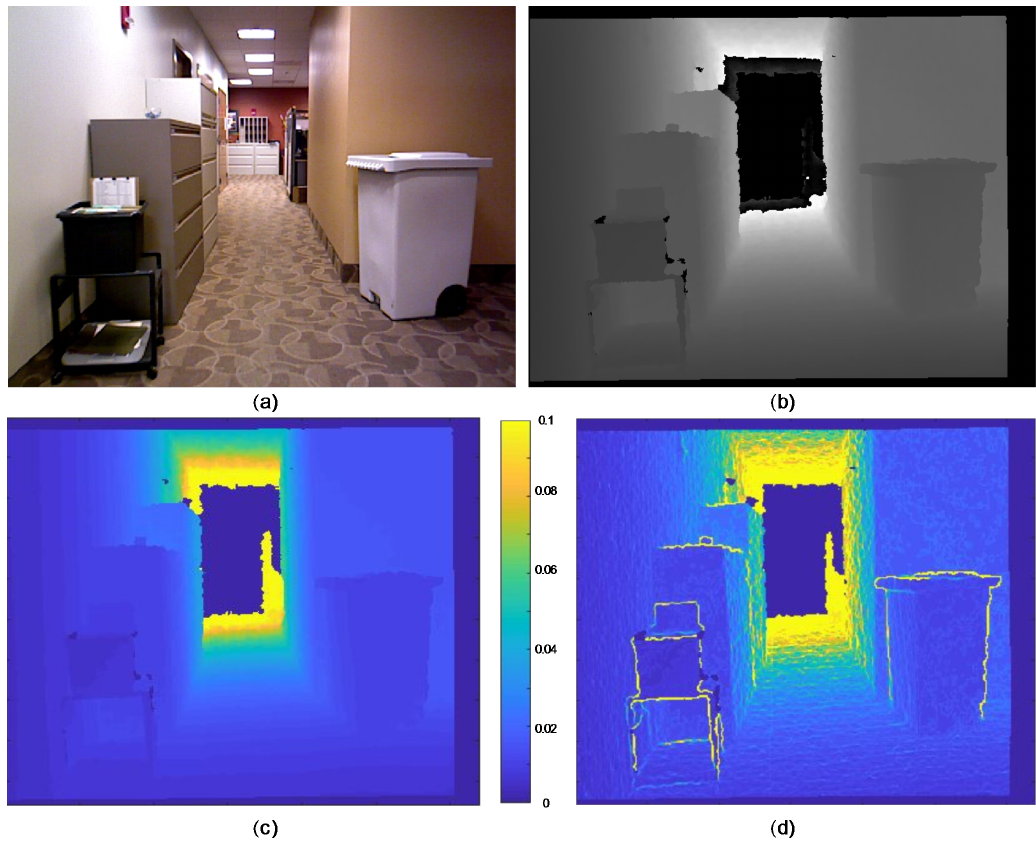
Figure 4. The uncertainty model developed in our algorithm. ( a ) An RGB image from the camera; ( b ) a depth image from the camera; ( c ) a result from the uncertainty model using independent pixel methods; ( d ) a result from the uncertainty model using our